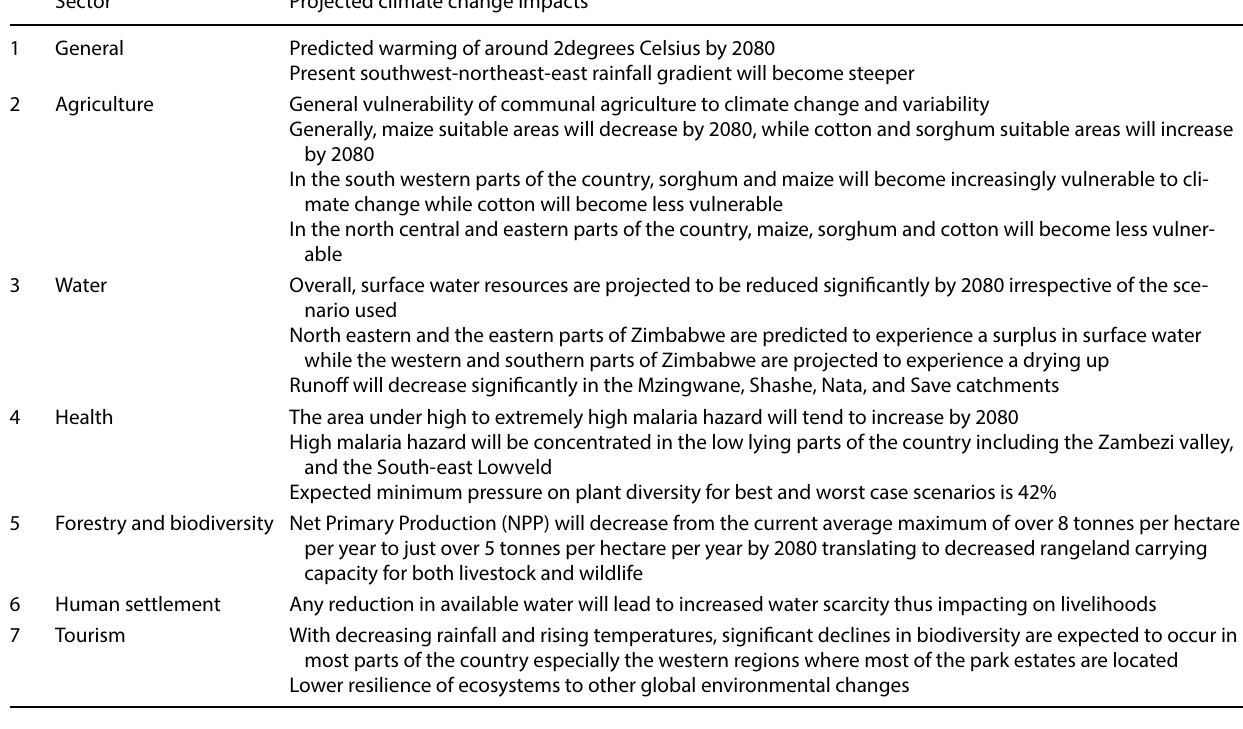
Table 4 Projected climate change impacts by sector in Zimbabwe. (Adopted from [251])